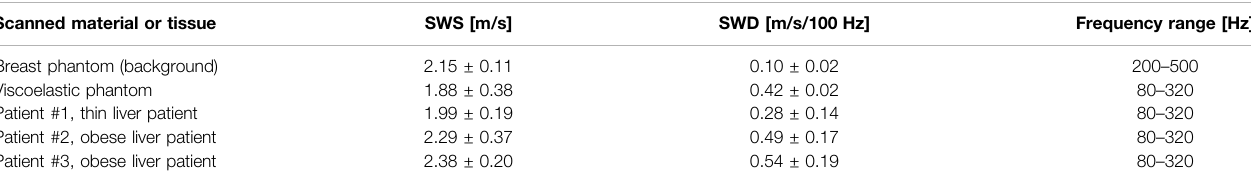
TABLE 1 | SWS and SWD estimations in phantoms and in vivo liver obtained with US-RSWE [15]. Scanned material or tissue Breast phantom (background)